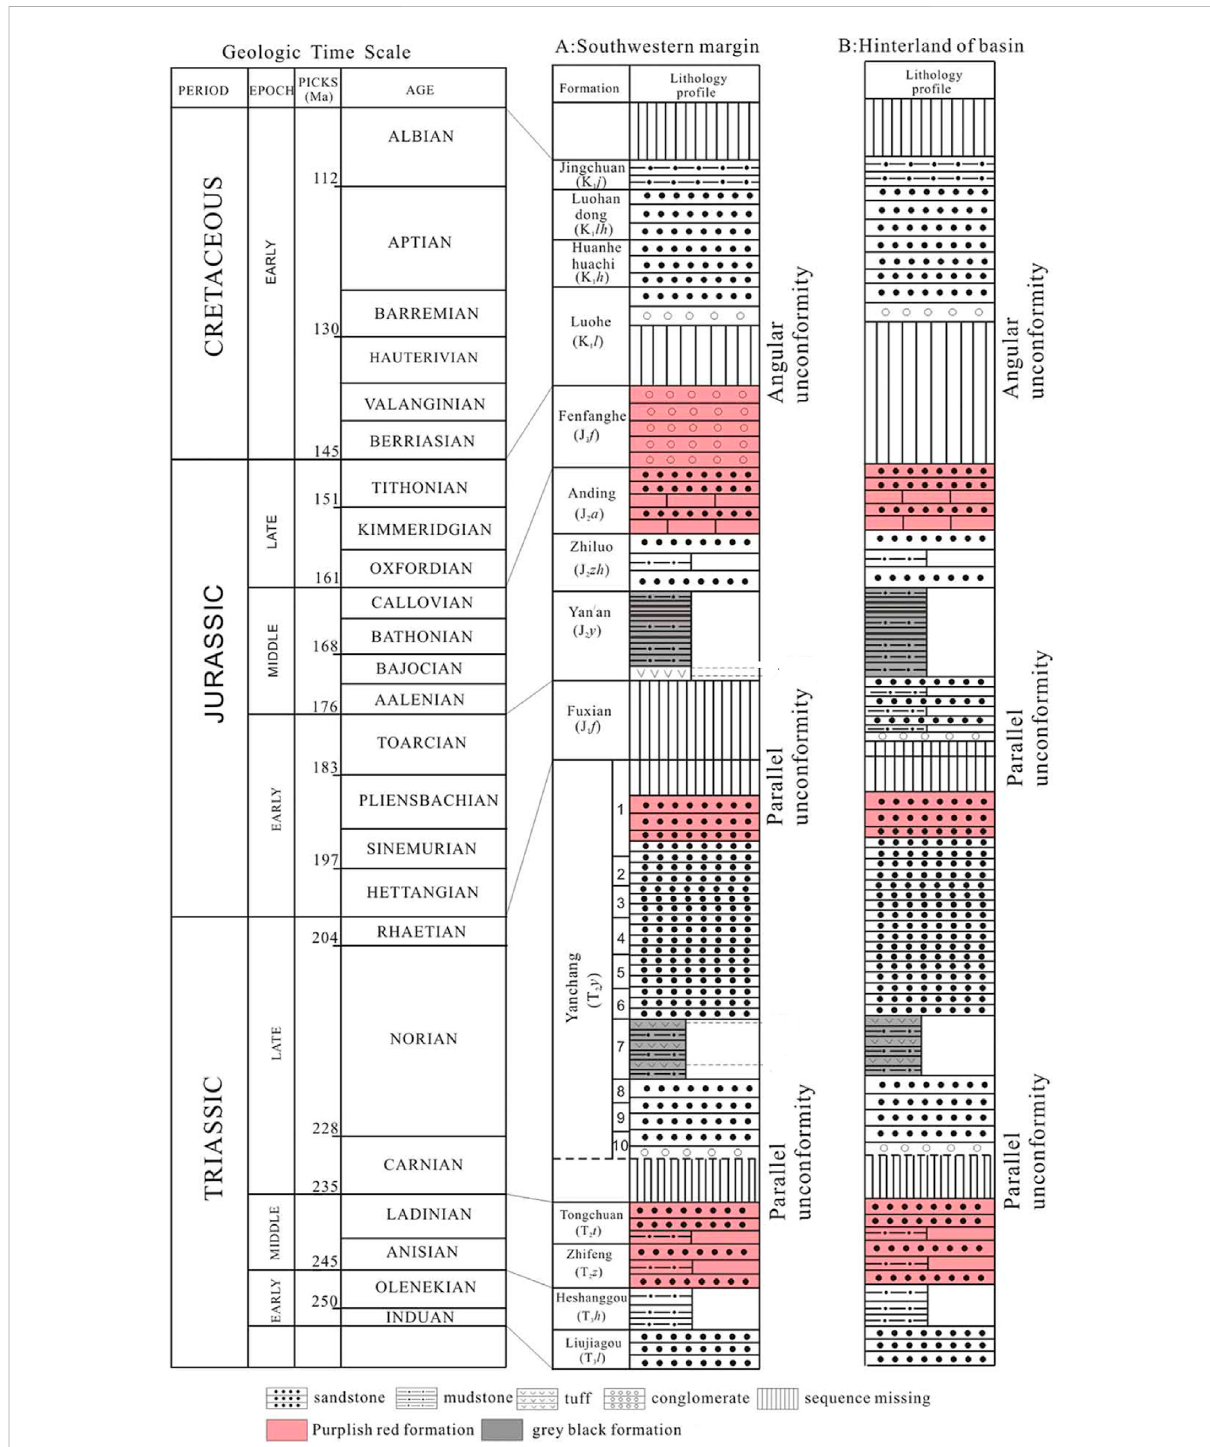
FIGURE 2 DivisionofstratigraphicunitsintheOrdosBasin(modi fi edafterLietal.,2016). (A) ThesouthwesternmarginoftheOrdosBasin; (B) Hinterlandof the Ordos